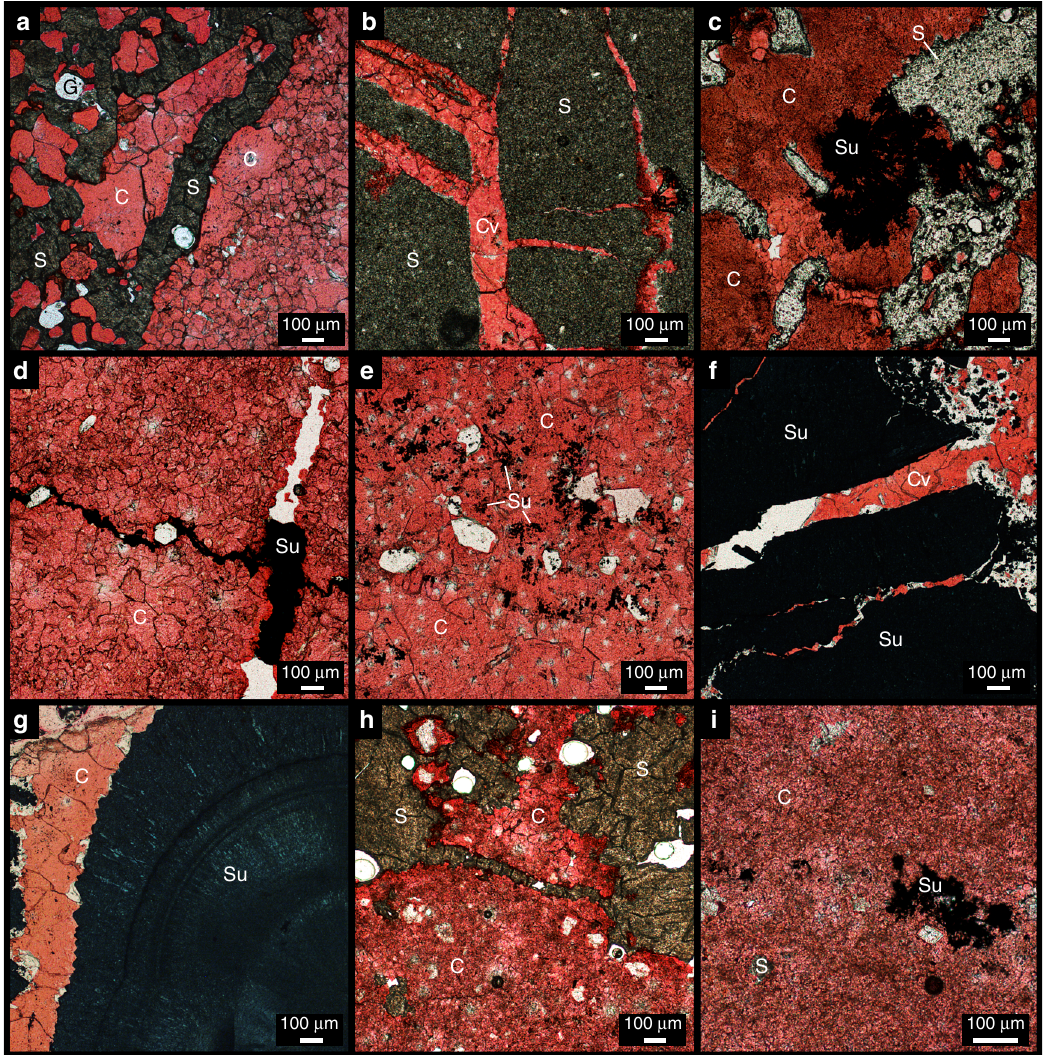
Fig. 4 Photomicrographs displaying paragenetic relationships between reduced sulfur phases (elemental sulfur and sul fi de) and carbonate. a – c Boling Dome, d Davis Hill Dome, e – g Hockley Dome, and h , i Main Pass Dome. Labels correspond to Gypsum (G), host carbonate (C), vein carbonate (Cv), yellow elemental sulfur (S), and metal sul fi de (Su) phases. Red stain indicates calcium